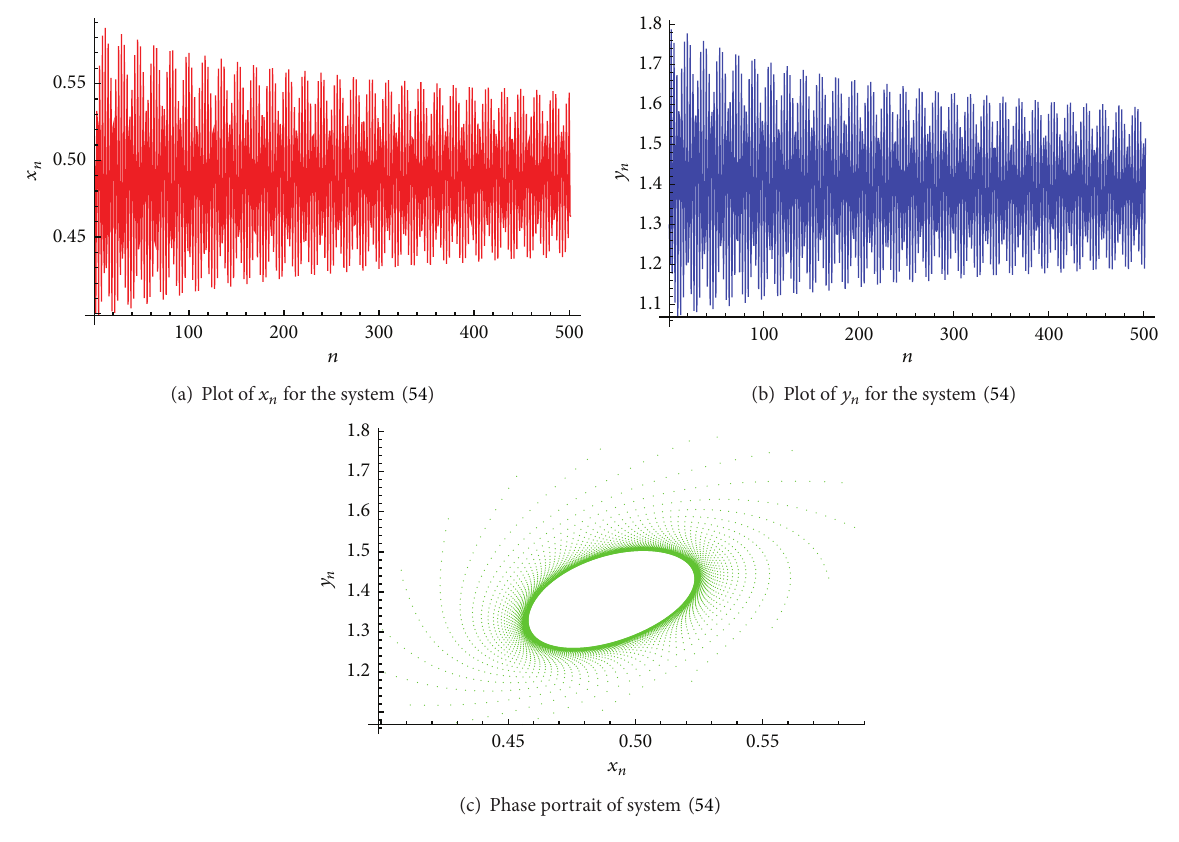
Figure 5: Plots for the system